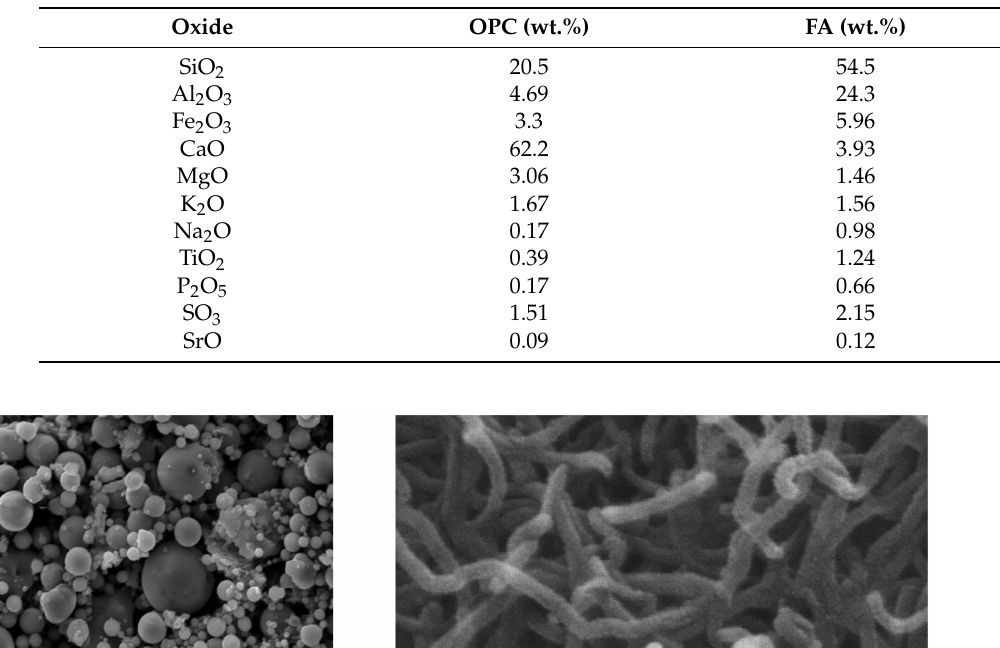
Table 1. Chemical compositions of OPC and FA.